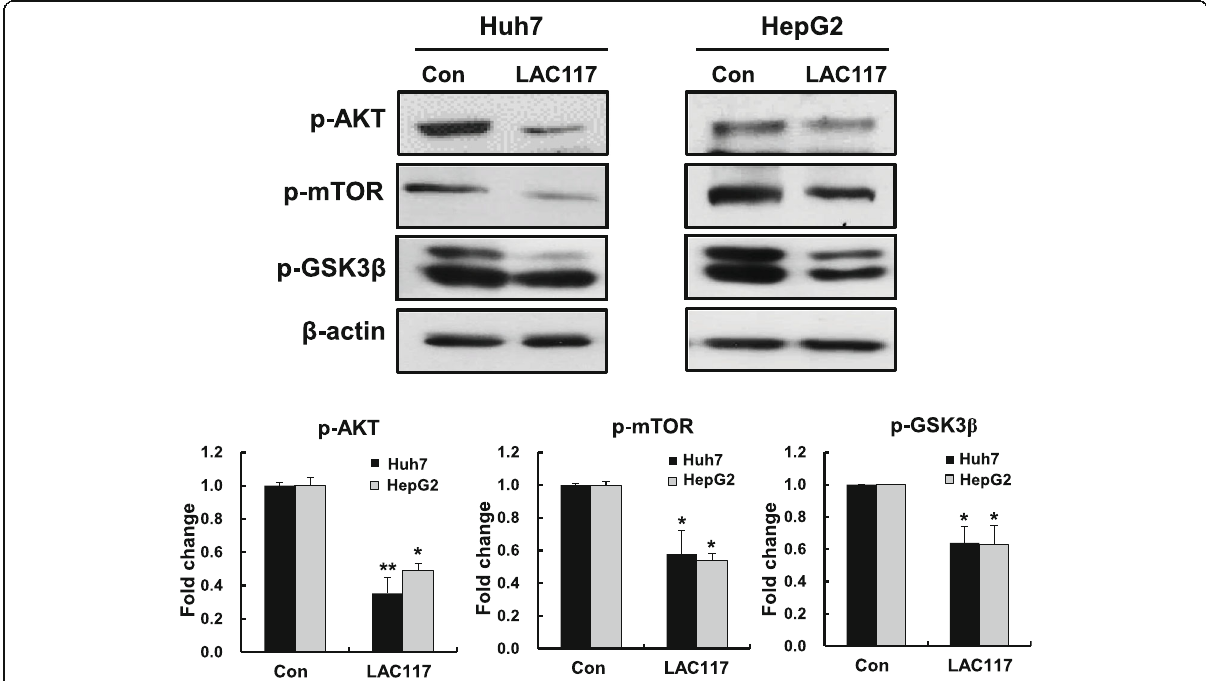
Fig. 4 Effect of LAC117 on PI3K/AKT signaling pathway in HCC cells. To investigate the effect of LAC117 on PI3K/AKT signaling pathway, HepG2 and Huh7 cells were treated with 100 μ g/mL of LAC117 for 1 h, and expression levels of p-AKT, p-mTOR, p-GSK3 β , and β -actin were determined by Western blotting analysis. Data are represented as the mean ± SEM from triplicate experiments (* P < 0.05 and ** P < 0.01 vs